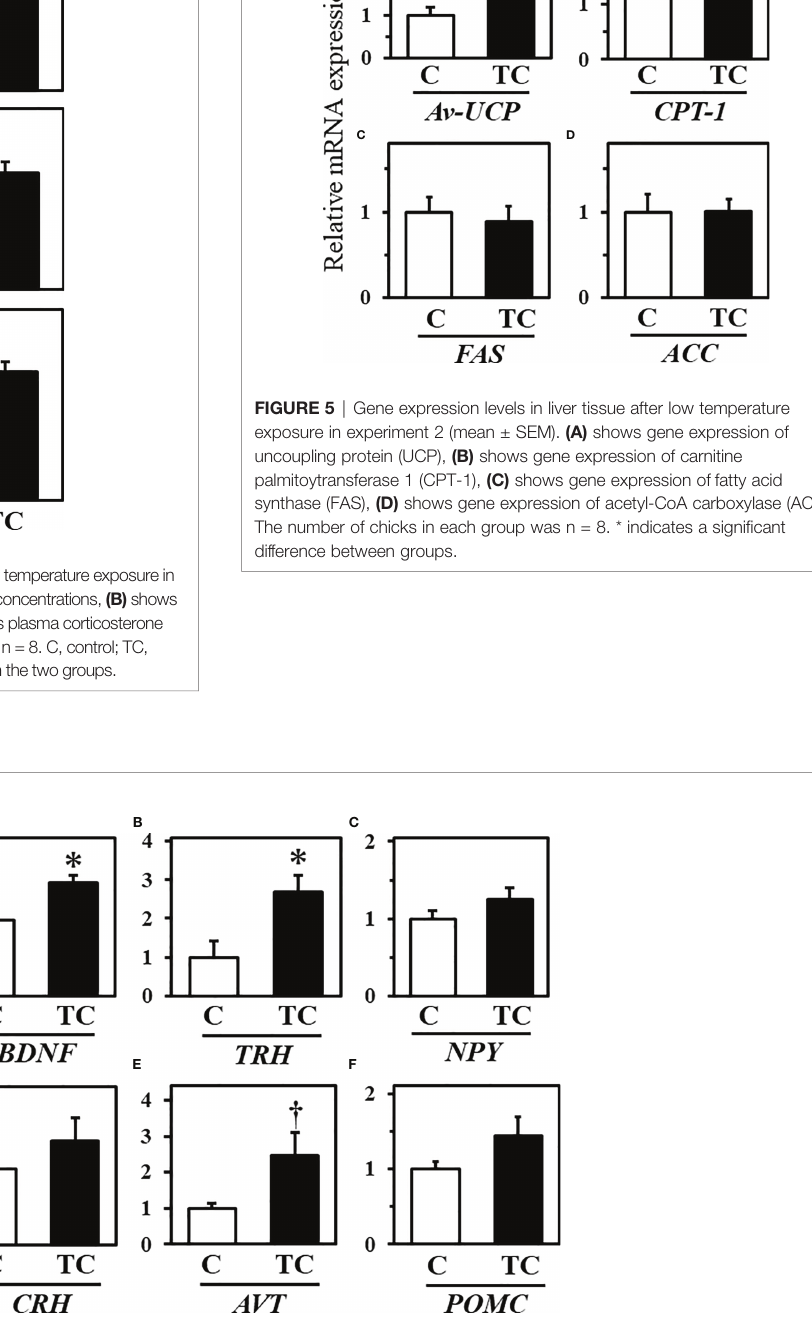
FIGURE 4 | Gene expression levels in hypothalamic tissue after exposure to low temperature in experiment 2 (mean ± SEM). (A) shows gene expression of brain- derived neurotrophic factor (BDNF), (B) shows gene expression of thyrotropin-releasing hormone (TRH), (C) shows gene expression of neuropeptide Y (NPY), (D) shows gene expression of corticotropin-releasing hormone (CRH), (E) shows gene expression of arginine vasotocin (AVT), and (F) shows gene expression of proopiomelanocortin (POMC). The number of chicks in each group was n = 8.* Indicates a signi fi cant difference between groups.